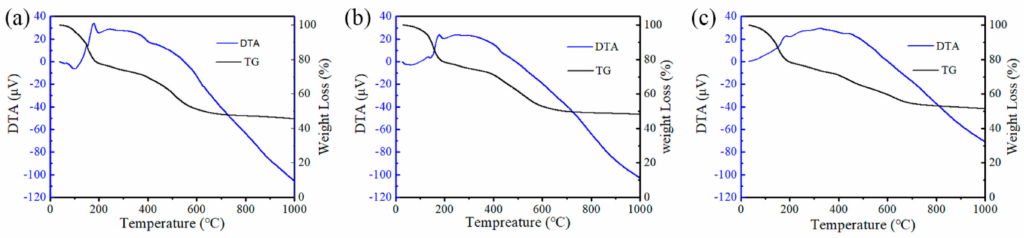
Figure 11. Thermogravimetric / di ff erential thermal analysis (TG / DTA) curves of ( a ) pure PF, ( b ) 5 wt.% GNP / PF, and ( c ) 5 wt.% GNP / PF with 1 wt.% Ni(NO 3 ) 2 · 6H 2